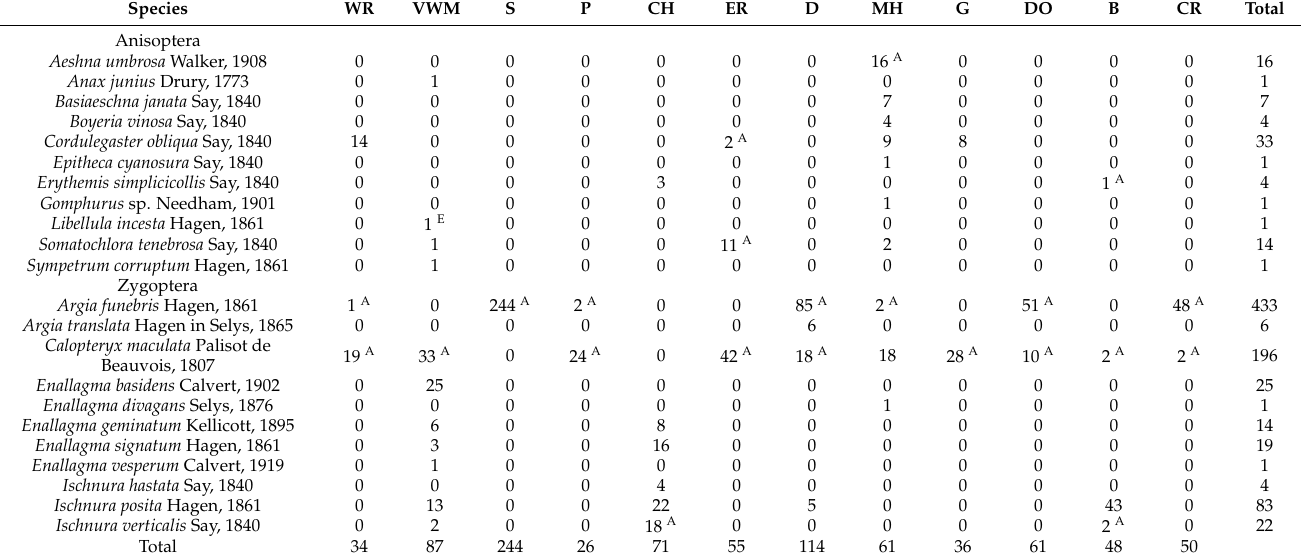
Table 2. Odonate assemblage data from resident larval detections made from multi-habitat and Slack Surber collections and breeding adult sightings at each stream. Counts represent larval abundance for one-hour-effort kick-net sampling from all different microhabitats within a sampling reach combined with any breeding/ovipositing adult detections and Surber data across three sampling seasons. See text (Methods) for more detail and Table 1 for stream code designations. Superscripts indicate a count that included adults ( A ) or exuviae ( E ).